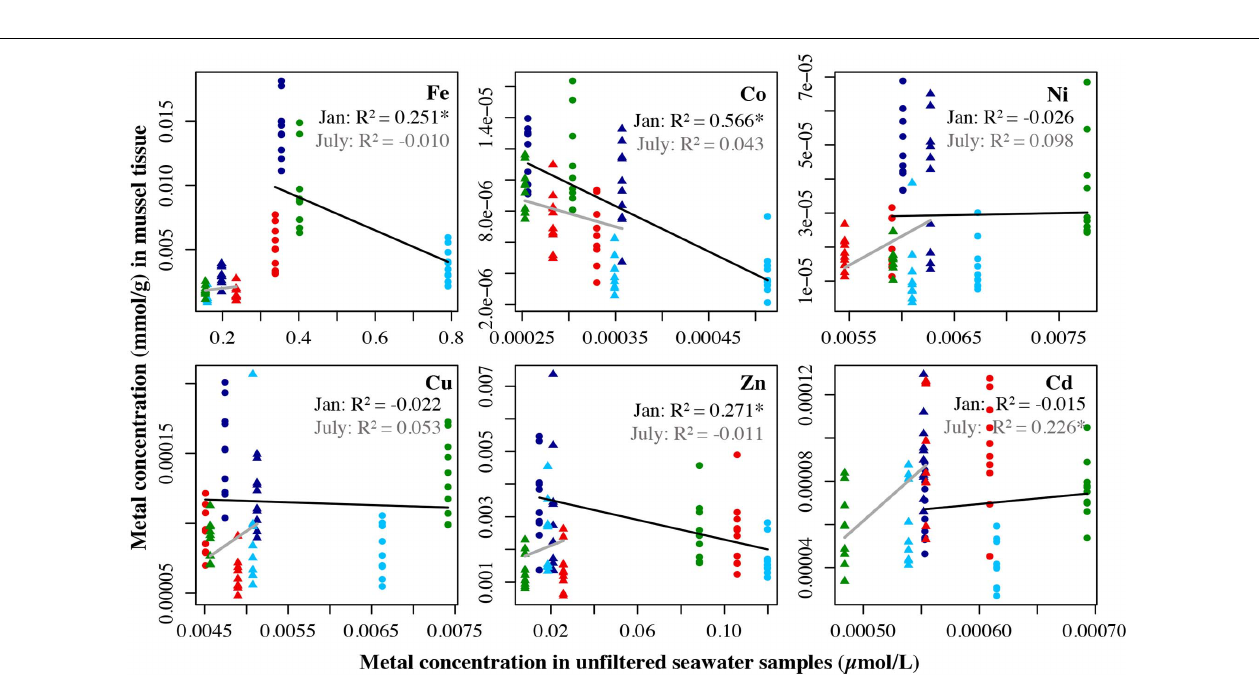
FIGURE 7 | Metal concentration ( µ mol/L) in unfiltered seawater samples from July 2018 and Jan 2019 plotted against the metal concentration of mussel tissue samples (mmol/g) from the four locations collected in July 2019 and Jan 2019. Circles represent the January samples, triangles represent the July samples. Dark blue = Carr Inlet 20 m, light blue = Carr Inlet 5 m, green = Point Wells 5 m, and red = Dabob Bay 5 m. Linear regression was used to assess the relationship between the two variables for January (black line) and July (gray line) separately. Asterisk indicates the adjusted the R 2 value is significant after Bonferroni correction (alpha of